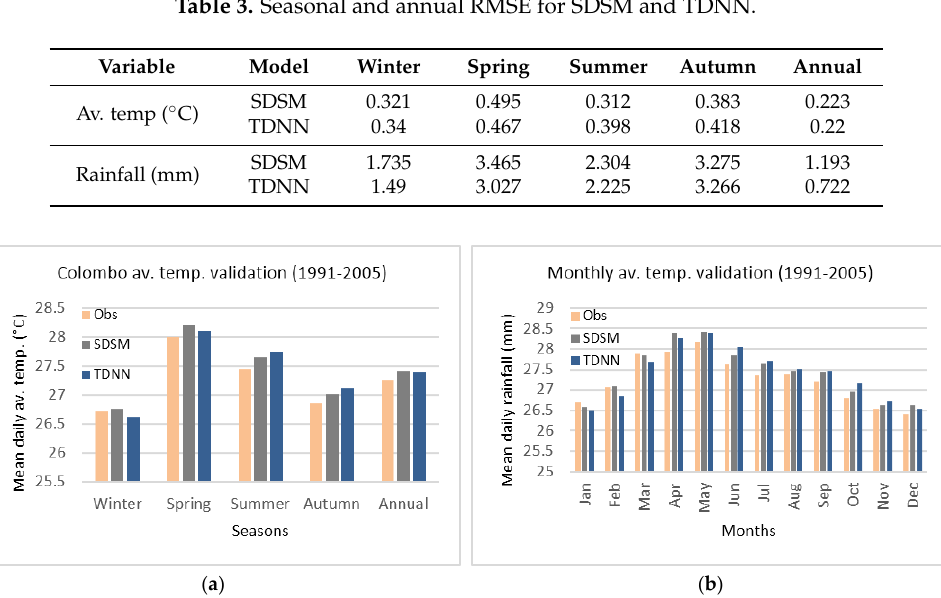
Figure 3. Average temperature validation ( a ) seasonal; ( b ) monthly.